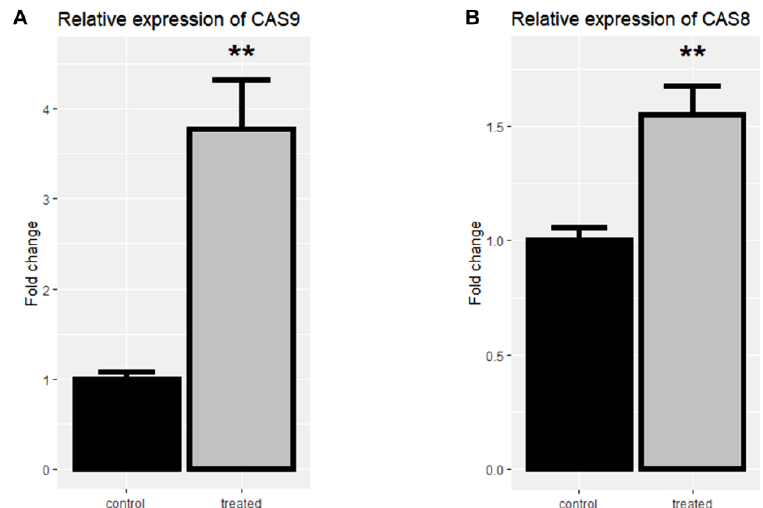
Figure 4. The relative mRNA expression of Casp-9 ( A ) and Casp-8 ( B ) in the SK-MEL3 cell line after treatment with 17.7 µg/mL rCTII. The expression of candidate genes was assessed by real-time PCR in the control and treated group. Our result illustrated that this protein potentially activated both intrinsic and extrinsic pathways related to apoptosis. Error bars display the ± SD. The independent t -tests assessed the p -values. p < 0.01 (**).